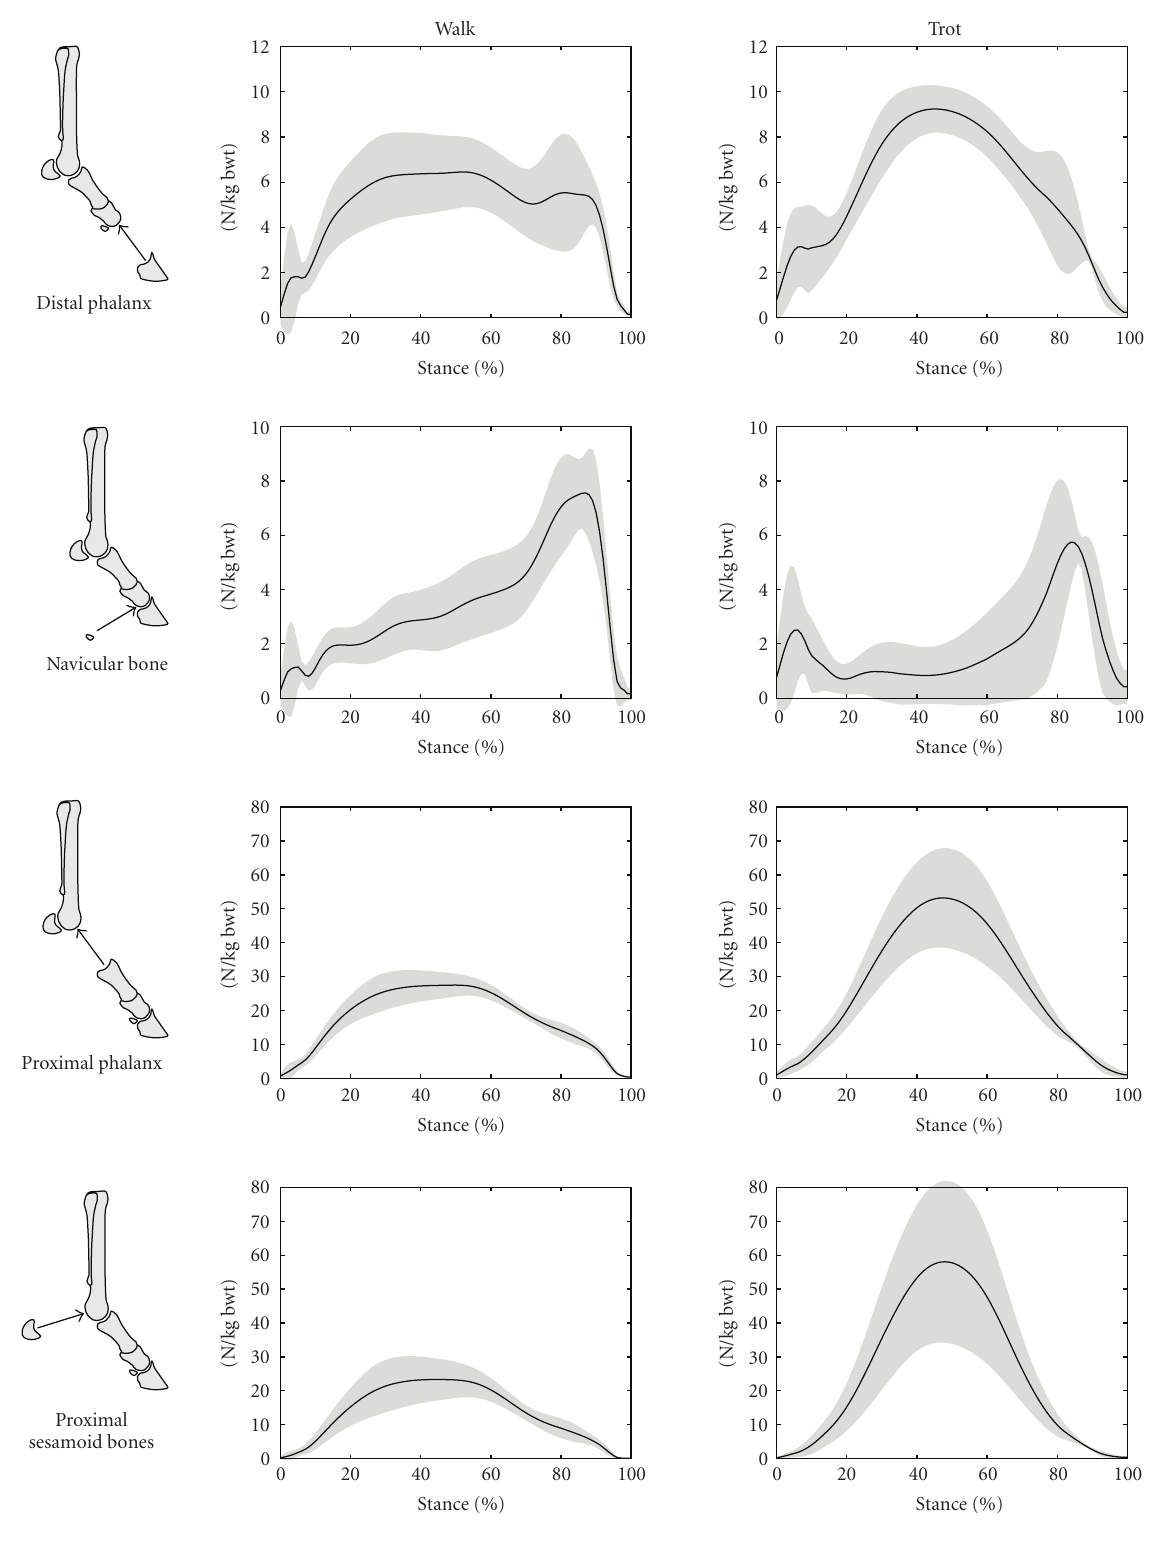
Figure 6: Magnitudes of calculated joint reaction force components from long bones and sesamoid bones in the co ffi n and fetlock joints for walking and trotting during the stance phase of the stride. The magnitudes are shown as solid lines with grey shading to represent ± 1SD. The stance phase of the stride was the time during which the vertical component of the ground reaction force was greater than 50 N. 0% of stride was the time of first hoof-ground contact, while 100% of stride was the time of last hoof-ground